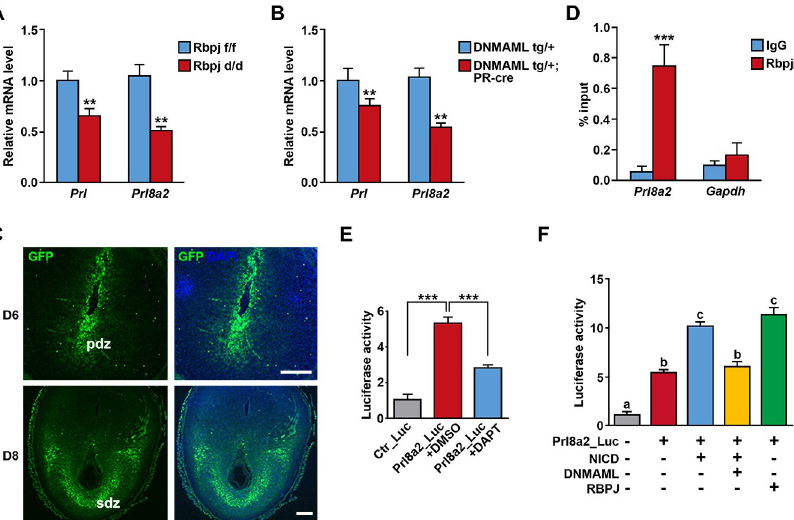
Fig 6. Prl8a2 was under the control of canonical Notch signaling. The relative mRNA level of Prl and Prl8a2 was examined in Rbpj f/f versus Rbpj d/d decidua (A) and DNMAML tg/+ versus DNMAML tg/+;PR-cre decidua (B). (C) GFP signals in implantation sites of mice carrying Rbpj responsive element-driven GFP on day 6 and 8. Nuclei were stained by DAPI. pdz, primary decidual zone; sdz, secondary decidual zone. Scale bar: 50 μ m and 100 μ m. (D) Chromatin immunoprecipitation assay showed the direct binding of Rbpj on Prl8a2 promoter. IgG was served as isotype control. Gapdh was served as negative control. (E) Luciferase analysis revealed Prl8a2 promoter activity in the presence of DAPT or DMSO. (F) Prl8a2 promoter activity was enhanced by NICD and RBPJ, which was reversed by DNMAML. Data in (A), (B) (D) and (E) are presented as mean ± SEM. �� p < 0.01, ��� p < 0.001, a vs b and b vs c: P < 0.01, a vs c: P <